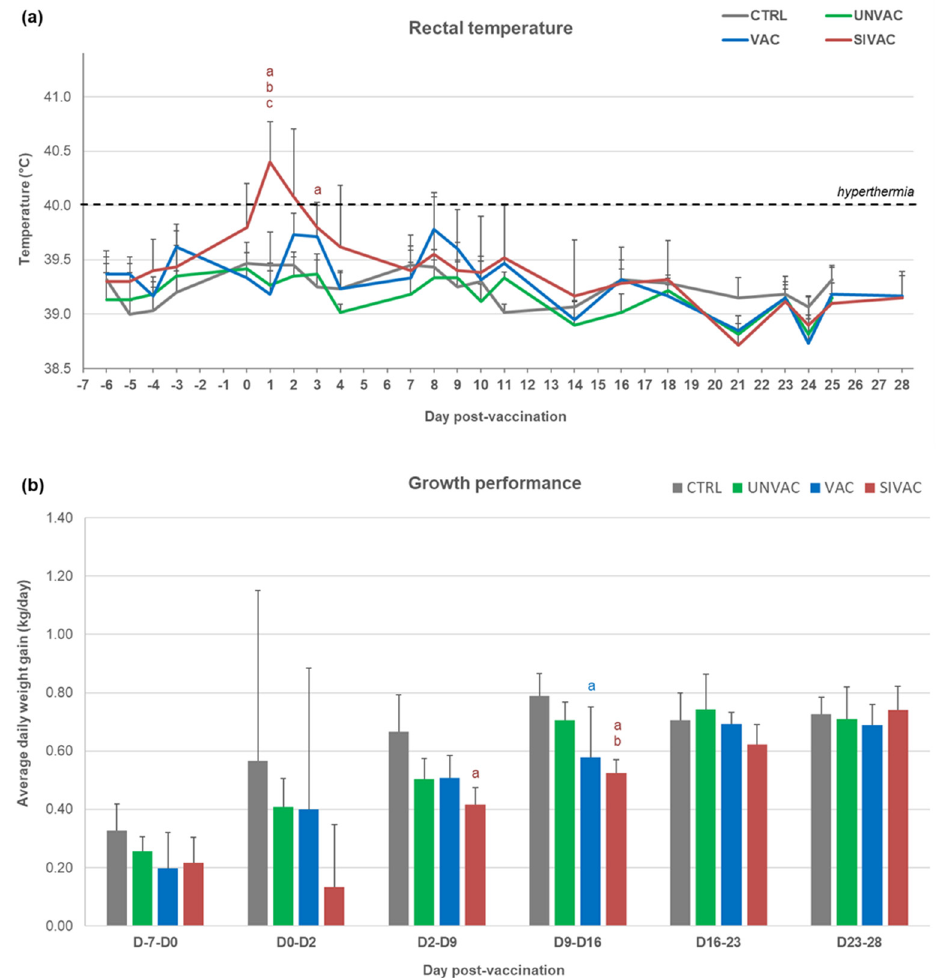
Figure 2. Clinical data recorded during the post-vaccination period (D0 to D28 pv). ( a ) Rectal temperature; ( b ) Average daily weight gain of piglets. All data are reported as the mean ( ± SD) of the results obtained from piglets in each group. Different letters (a–c) indicate that the considered group (specified by its color) was significantly different from the CTRL group (a), from the UNVAC group (b) or from the VAC group (c) with p < 0.05.